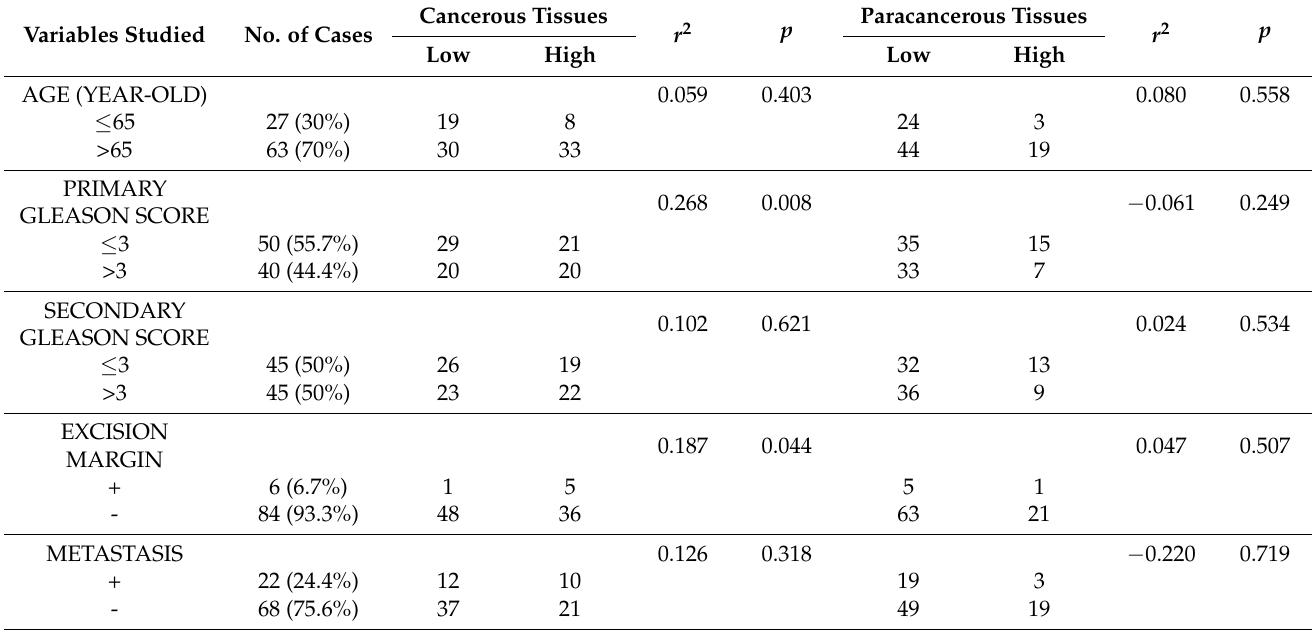
Table 1. Expression of UBE2C in relation to pathological and clinical